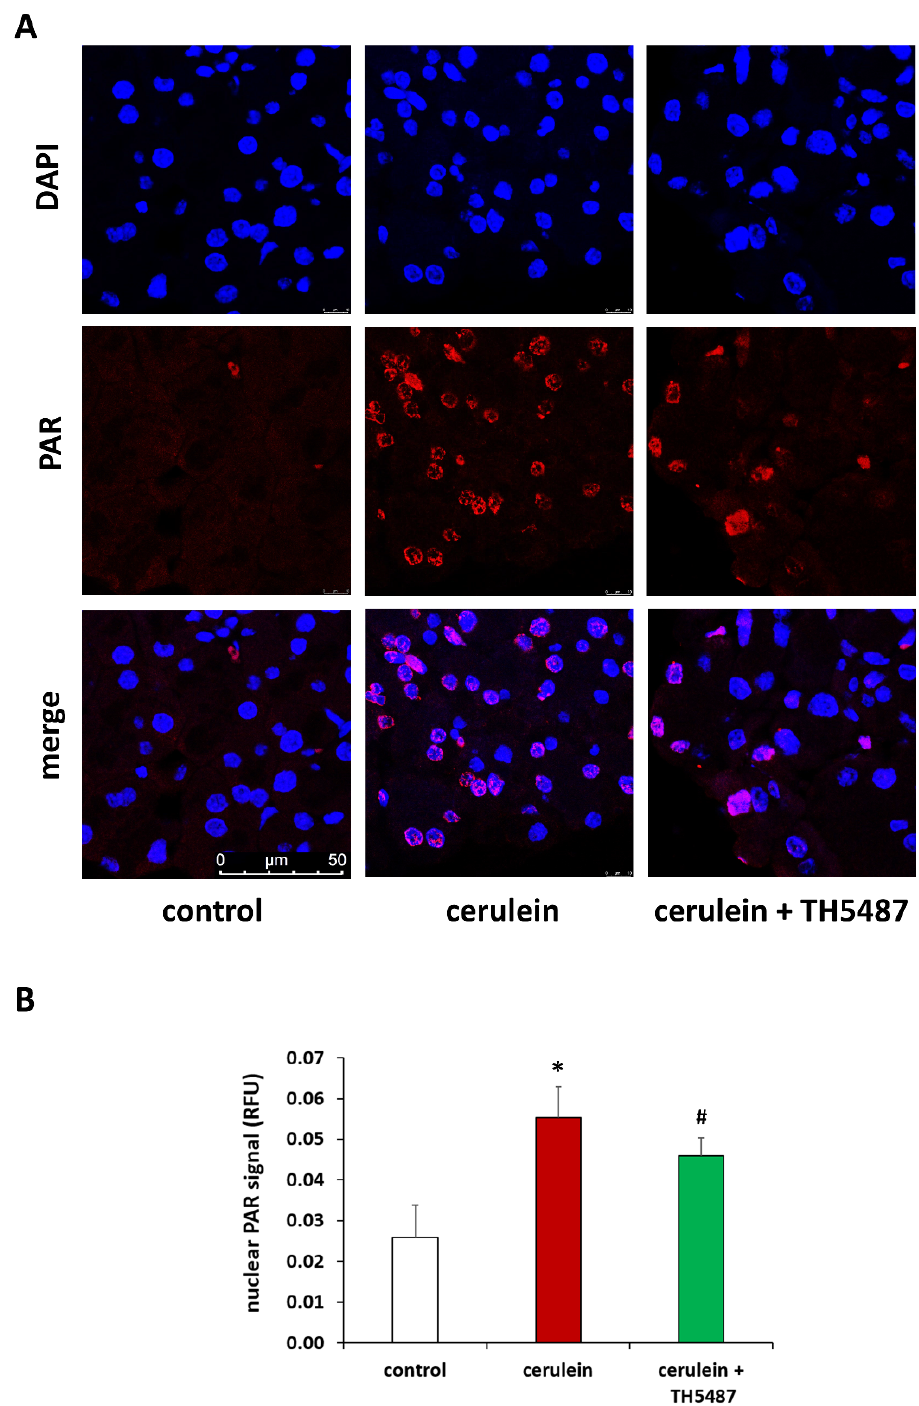
Figure 4. TH5478 reduces nuclear PARylation in AP. Representative images of pancreatic sections immunostained for poly(ADP ‐ ribose) polymers ( A ). Nuclear PAR formation increased in cerulein ‐ treated mice compared to the controls. PAR levels were significantly reduced after TH5487 treatment. Quantitation of PAR immunofluorescence signals ( B ). Values are presented as mean ± SD, n = 6. * p < 0.05 vs. control group, # p < 0.05 vs. cerulein group. Scale bars are 50 μ m. Based on the central role of PARP1 activation in oxidative stress ‐ induced regulated necrotic cell death [30,31], we set out to investigate how lower PARylation activity trans ‐ lates to cell death in TH5487 ‐ treated animals. In line with our expectations, we found that cerulein decreased the viability of primary pancreatic acinar cells (Figure 5A). Cell death